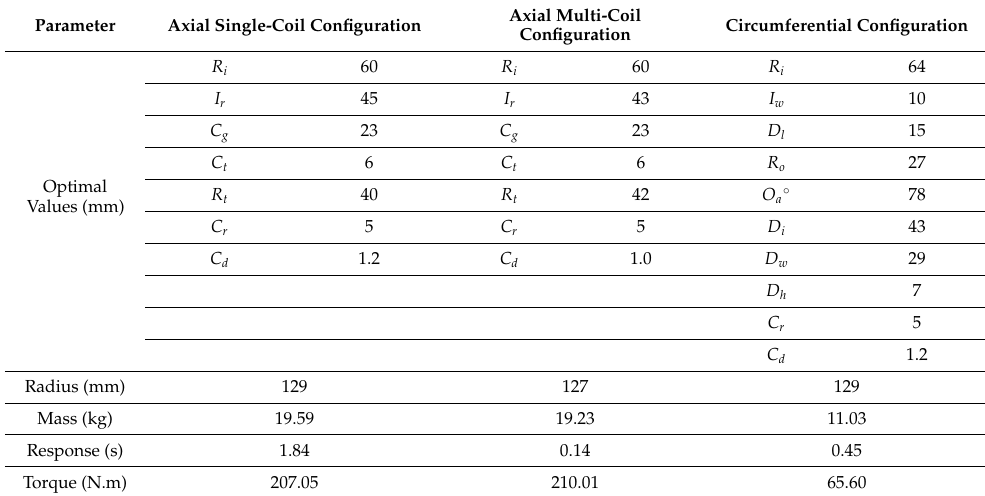
Table 8. Optimization results and comparison of